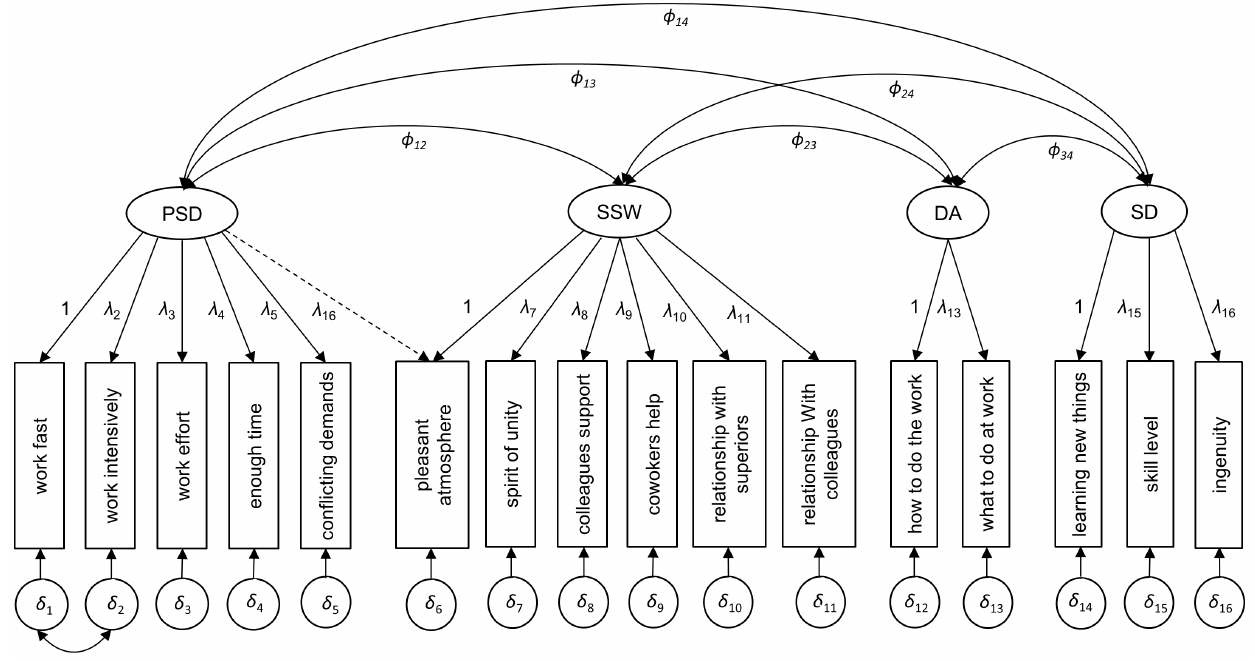
Figure 1. Revised conceptual Demand-Control-Support model.